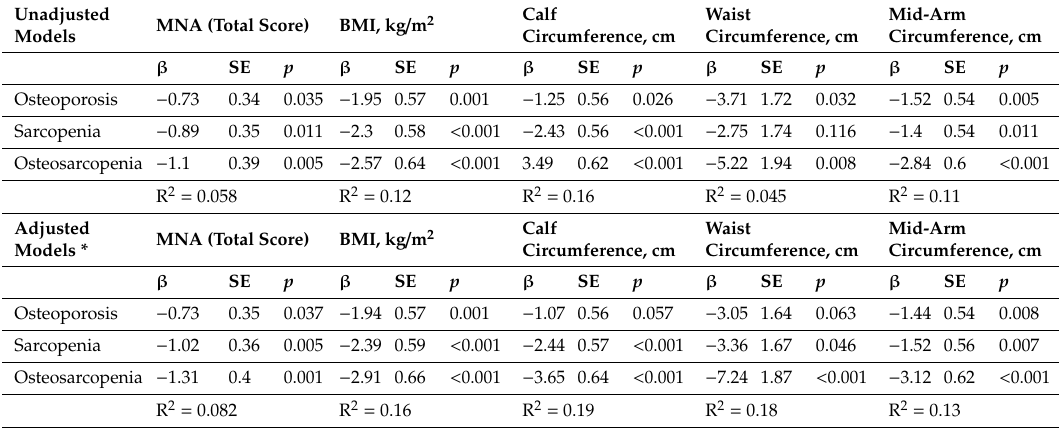
Table 3. Multiple linear regression models with nutritional parameters as dependent variables.